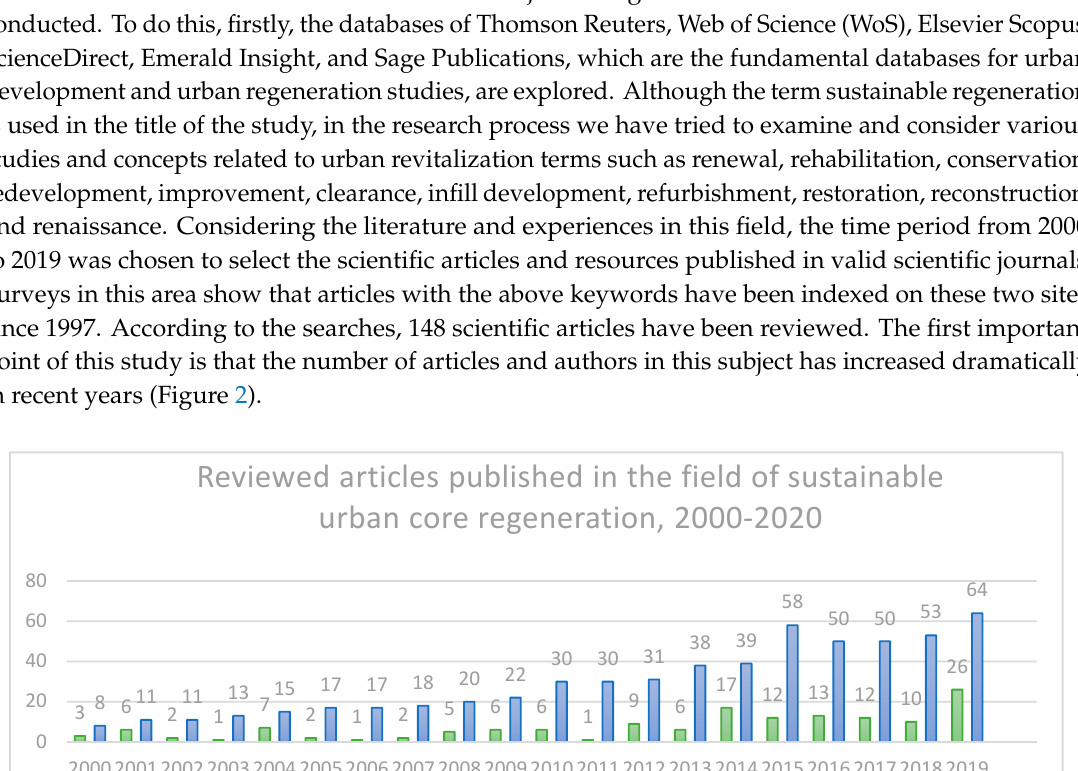
Figure 1. Flowchart of the research methodology.